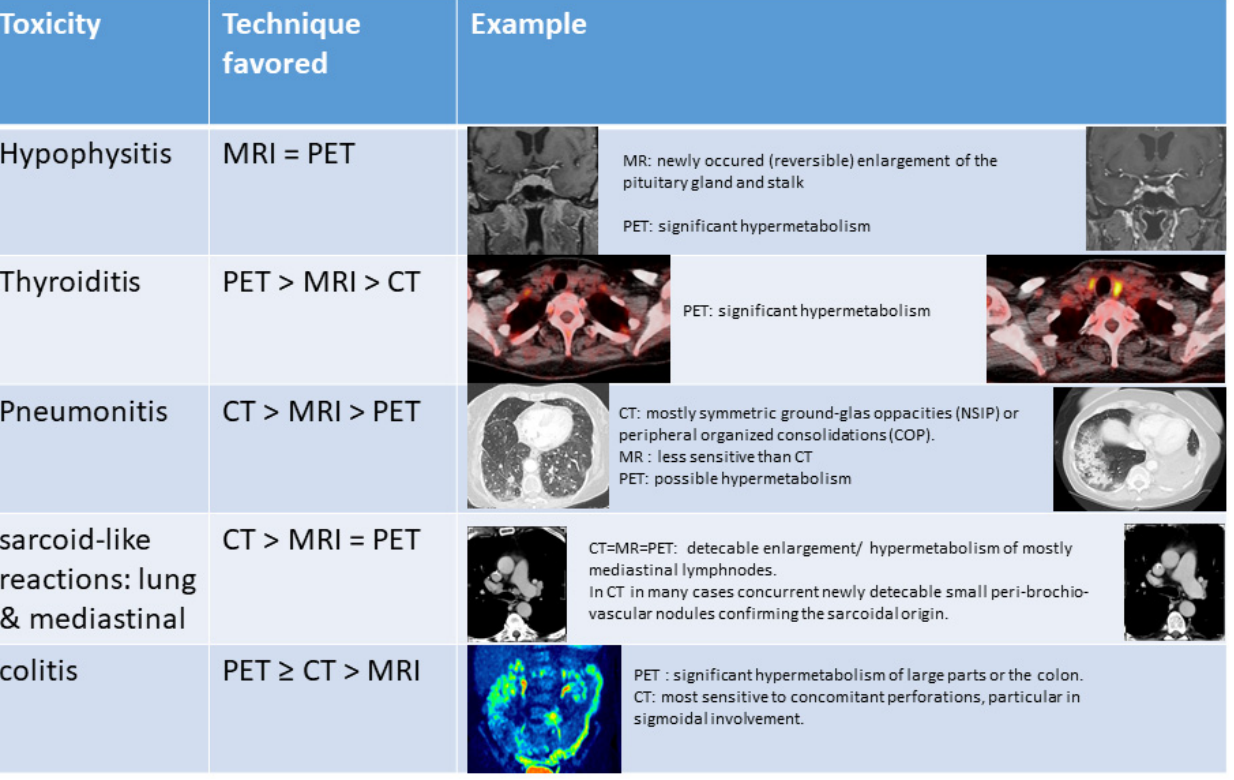
Figure 3. Preferred imaging modality for the characterization of immune-related side effects ( PET refers to 18 F-FDG-PET) .